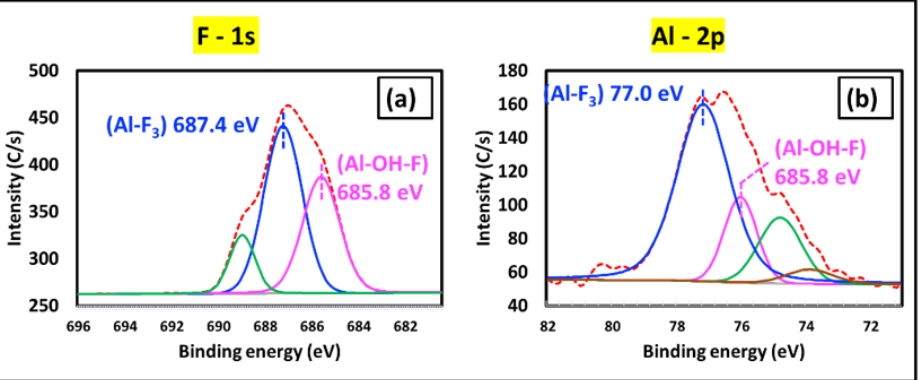
Figure 12. ( a ) F-1s core level and ( b ) Al 2p core level X-ray photoelectron spectra of the corroded Al pad immersed in 5 ppm F − , pH 5 solution after 3 h (red dotted lines reveal the original spectra before decon- volution).